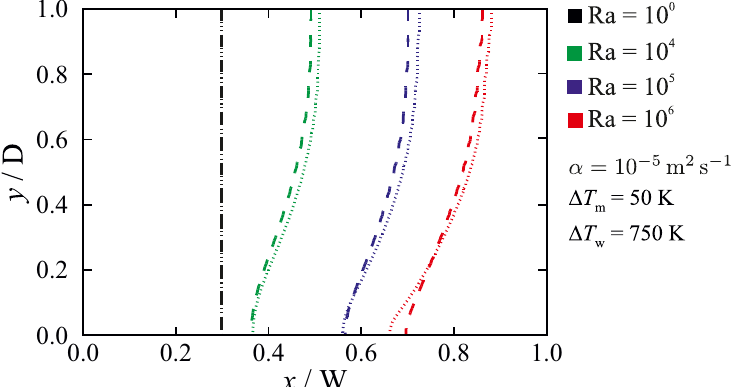
Figure 8. The influence of the permeability coefficient on predicted liquidus-line ( f L = 1) position for different Rayleigh numbers ( ∆ T m = 50K; ∆ T w = 750K; dashed lines: C = 1 × 10 8 kgs − 1 m − 3 ; dotted lines: C = 1 × 10 4 kgs − 1 m − 3 ). The results are given for Fo = 9, in which steady-state solutions are achieved.